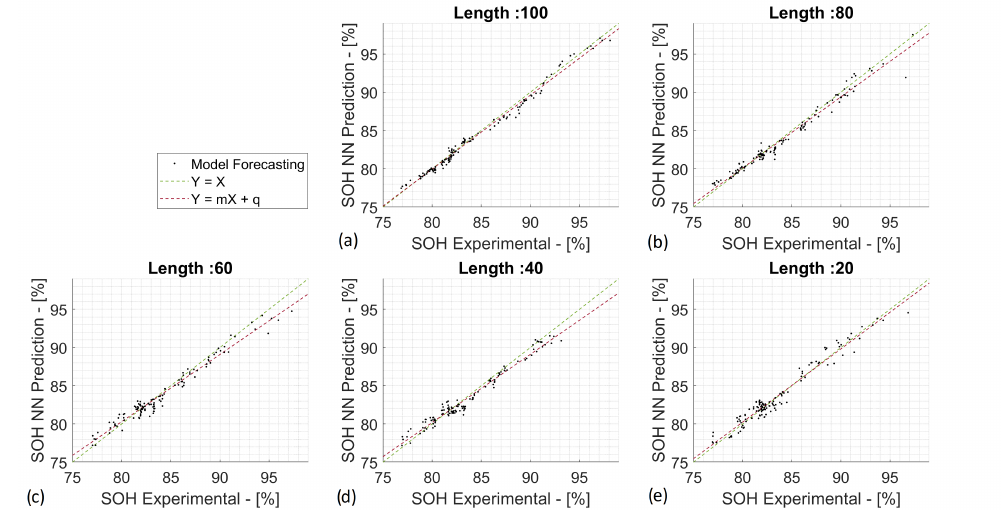
Figure 9. Best neural network regression performance. ( a ) refers to the full charging length equal to 100%, ( b ) refers to the partial charging length equal to 80%, ( c ) refers to the partial charging length equal to 60%, ( d ) refers to the partial charging length equal to 40%, ( e ) refers to the partial charging length equal to 20%. The black points represents the correlation points between predicted and target values. The green dashed line is the bisector, and the red dashed line is the fitting regression line. The regression parameters can be observed in Table 3. The predicted SOH points over the entire cycle aging test are those of test set for perfomance